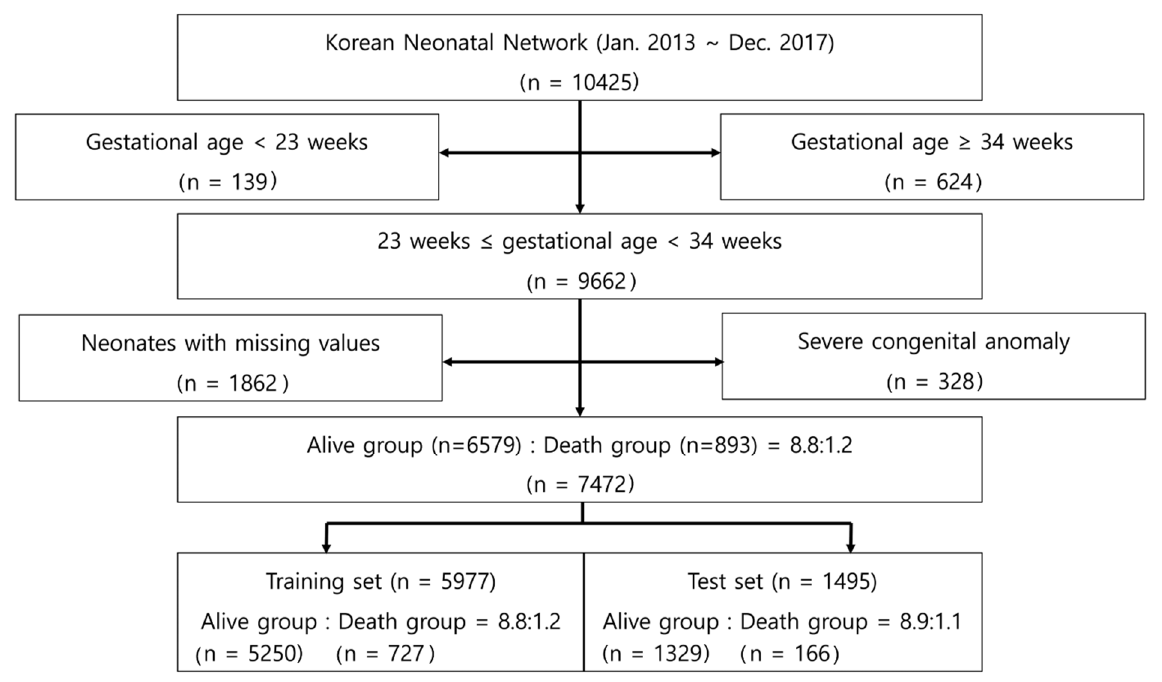
Figure 1. Flowchart outlining study methodology.